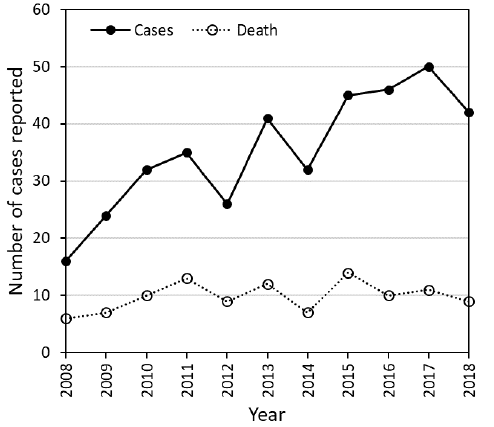
Figure 1. Number of confirmed cases and deaths of V. vulnificus in 32 Florida counties reported by the Florida Department of Health for 2008-2018.